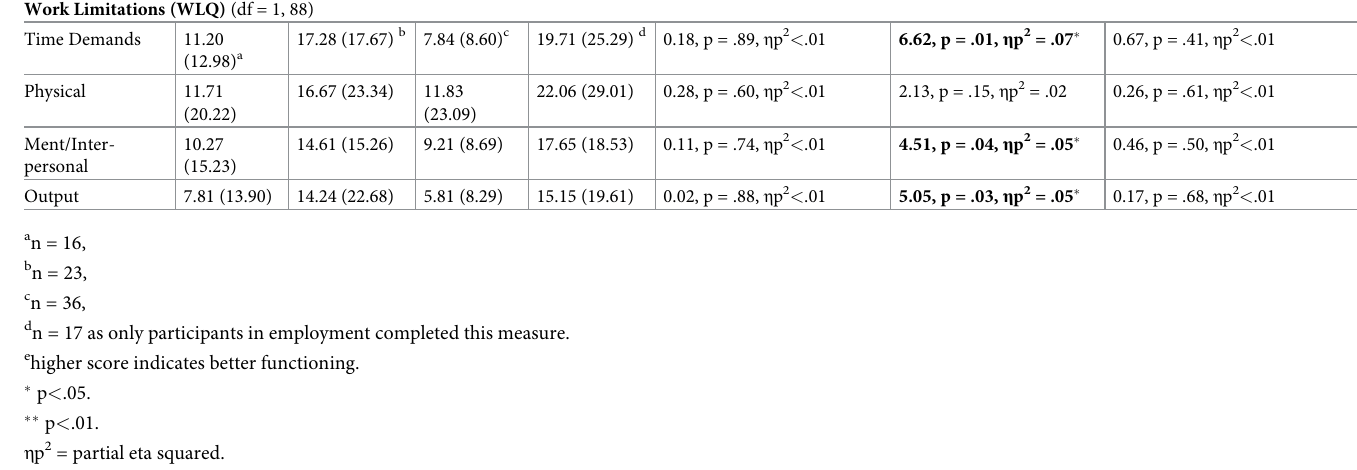
A series of 2 (Group: single/repetitive) x 2 Sex: male/female) ANOVAs were conducted to examine the effect of multiple TBI on the outcome measures. These data are summarised in Table 4. The group with repetitive TBI reported significantly more symptoms/greater symp- tom burden with medium effect sizes on the RPQ total, cognitive and somatic subscales than those in the single TBI group. Women had significantly higher RPQ total and somatic subscale scores than men, with medium effect sizes. A significantly greater proportion (small to medium effect) of those with repetitive TBI met the DSM-IV symptom criteria for PCS (n = 33, 36.7%) compared to the single injury group (n = 13; 21.3%; X 2 (1) = 4.05, p = .04, V = .17). As shown in Fig 3a, the percentage of males above the cut-off did not differ between the groups ( X 2 (1) = 0.59, p = .44, V = .09), but there was a significantly greater proportion of females with repetitive TBI above the cut-off compared to those with single TBI, a medium effect ( X 2 (1) = 6.90, p = .01, V = .31). There was no significant association between the